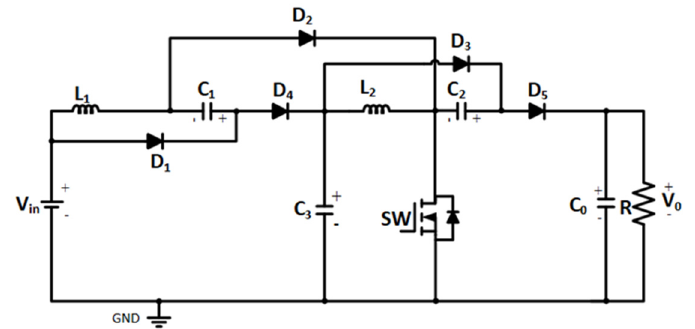
Figure 4. Circuit configuration of dual voltage lift proposed at [37].